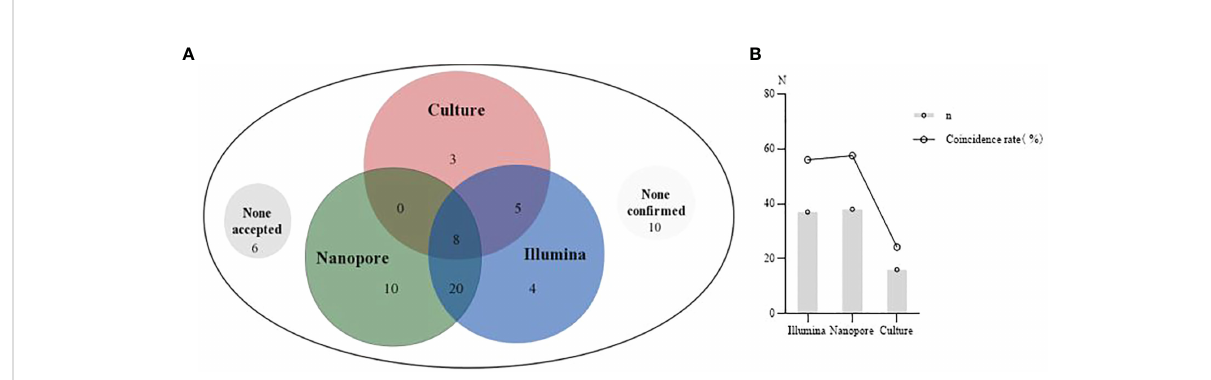
FIGURE 4 The clinical diagnosis based on Illumina, Nanopore and culture. (A) , A Venn diagram of diagnosis based on the three methods. None accepted, none results of the three methods were accepted by clinicians. None con fi rmed, none results of the three methods were consistent with clinical diagnosis. (B) , Comparison of the coincidence rate between the three methods with the clinical etiological